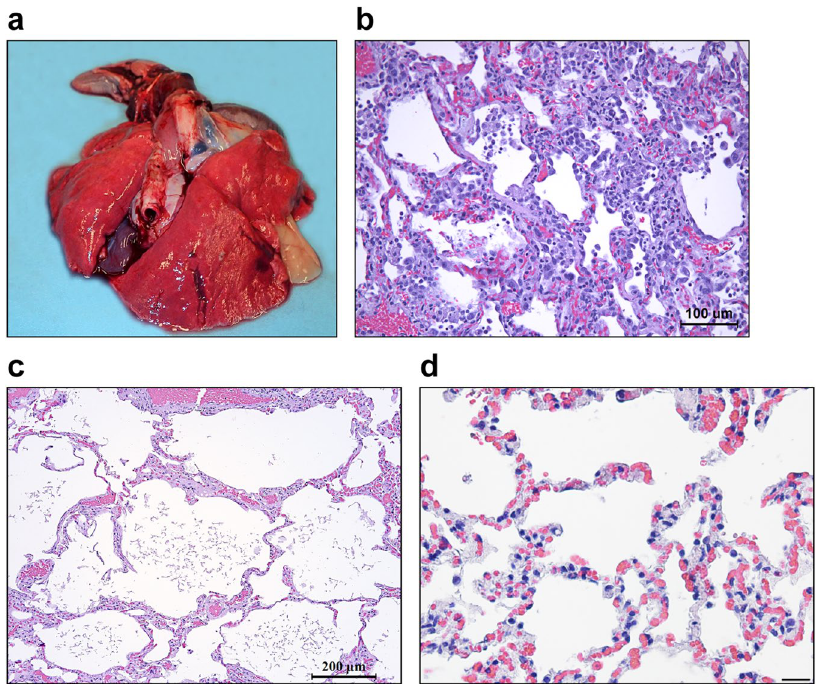
Figure 3. Pulmonary pathology in rhesus macaques inoculated with MERS-0. ( a ) Diffuse, mild pulmonary congestion. NHP3 at day 5 of MERS post-inoculation. ( b ) Multifocal, mild interstitial pneumonia characterized by type II pneumocyte hyperplasia and alveolar edema, fibrin and hemorrhage. NHP6 at day 5 of MERS post- inoculation. HE; ( c ) Multifocal alveolar emphysema containing small amount of eosinophilic to basophilic fibrillary material. NHP6 at day 5 of MERS post-inoculation. HE. ( d ) Day 30 H&E of lung demonstrating clearance of proteinaceous material and resolution of mild interstitial pneumonia.